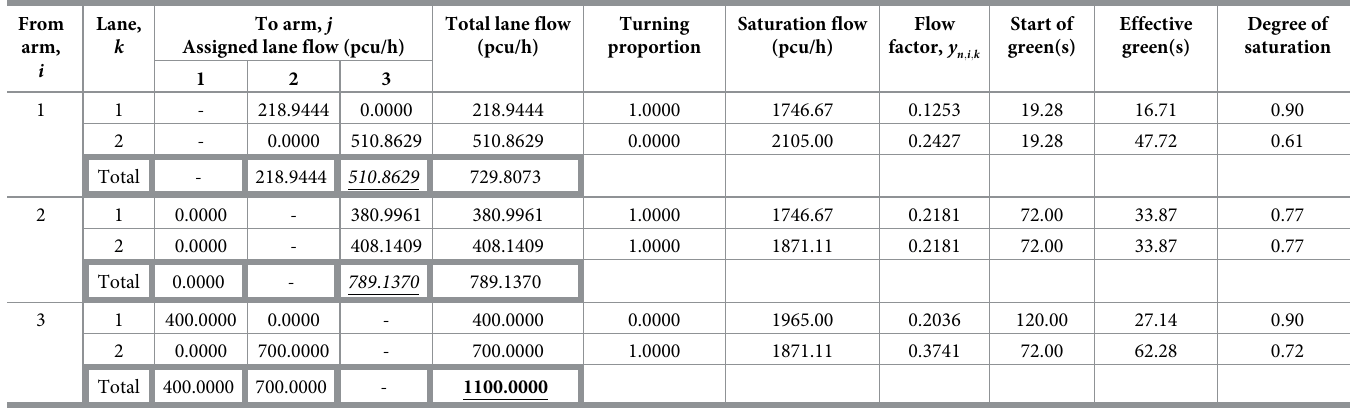
= z ¼ W = z ¼ 32 : 9 s (maximized), and z ¼ 1 = 120 : 0 . o ¼ 2 ; d ¼ 4 ; h o ; d ¼ 1 o ¼ 4 ; d ¼ 2 ; h o ; d ¼ 1